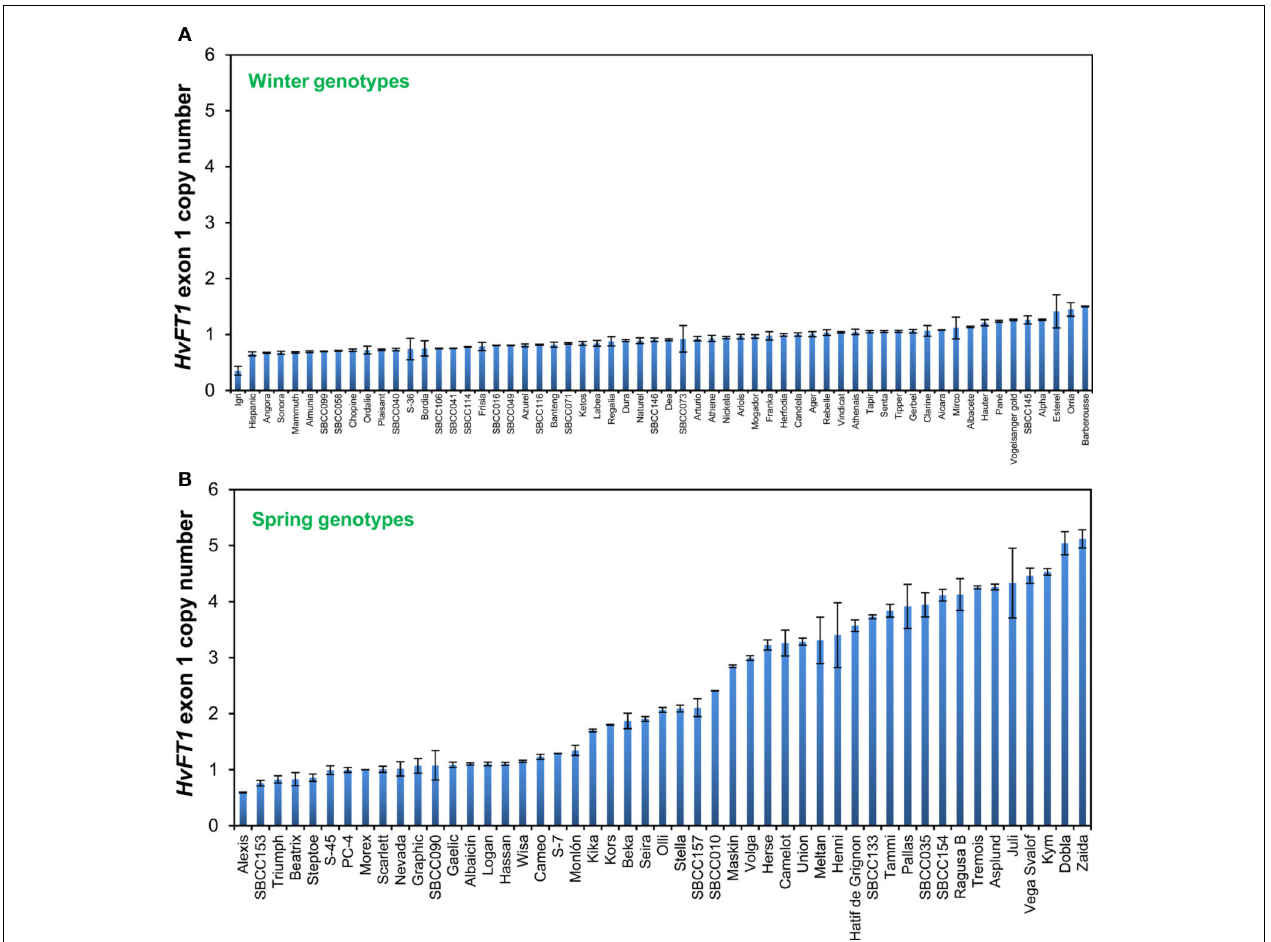
FIGURE 1 | Determination of copy number variation for the first exon of HvFT1 in winter (A) and spring or facultative (B) barleys. Bars represent means ± s.e.m. Morex was used as the calibrator genotype (copy number = 1). SBCC, Spanish Barley Core